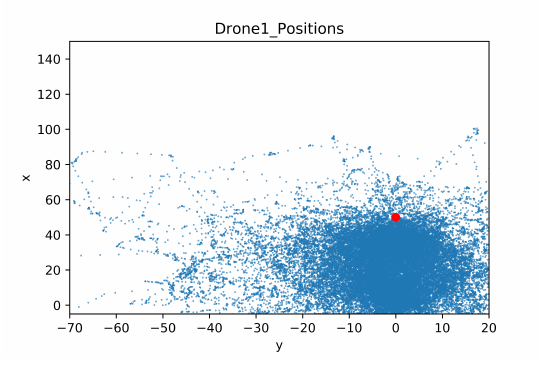
Figure 32. Drone Position Map for Case 1.3.